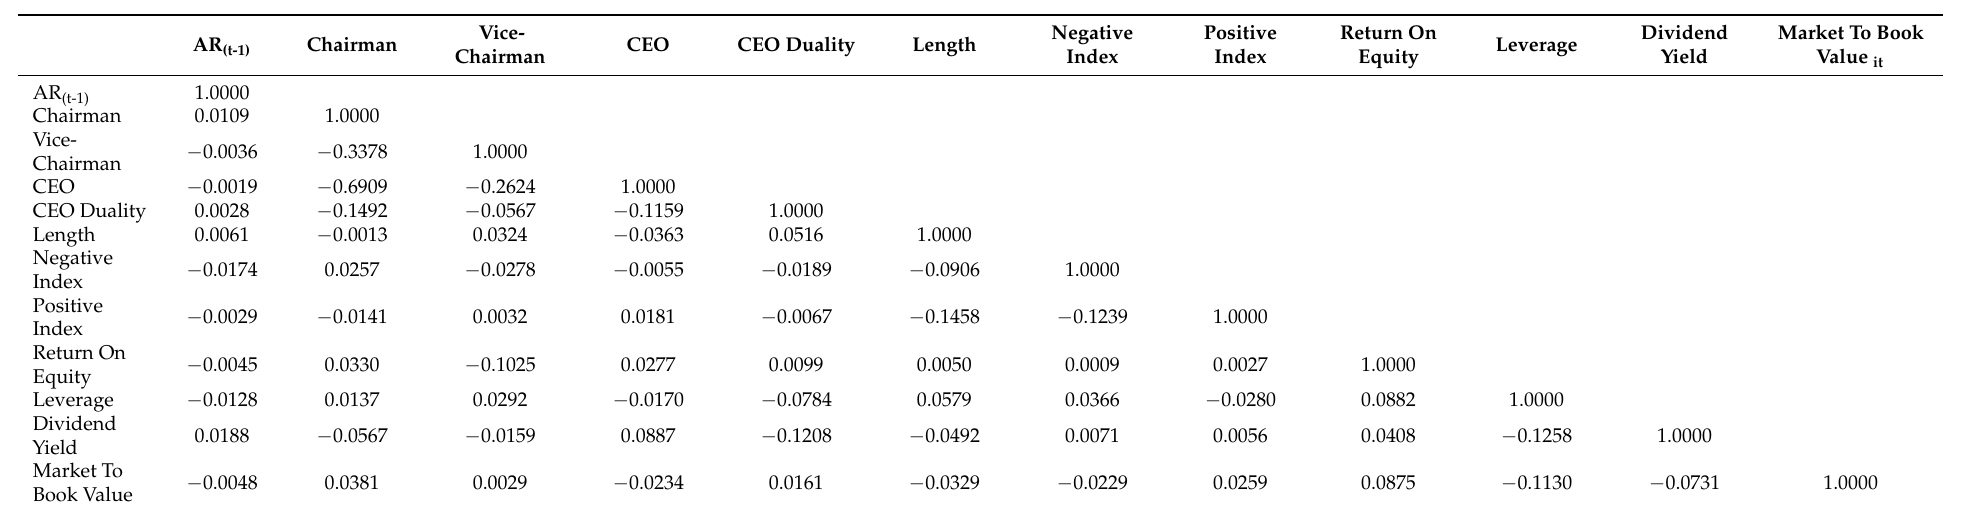
Table 5. Correlation